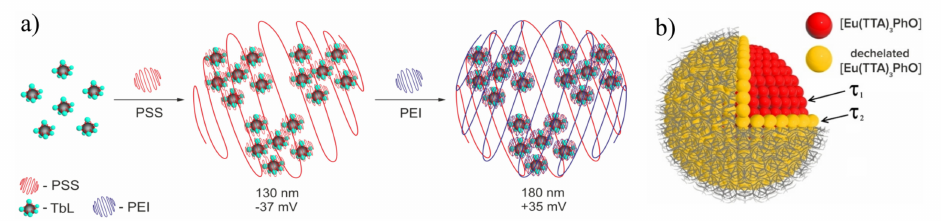
Figure 12. ( a ) Schematic illustration of nanoprecipitation method of nanoparticles formation. ( b ) Schematic illustration of two types of lanthanide-based blocks with different surface and bulk [Eu(TTA) 3 PhO] localization. Reproduced from Refs. [106,107] with permission from the